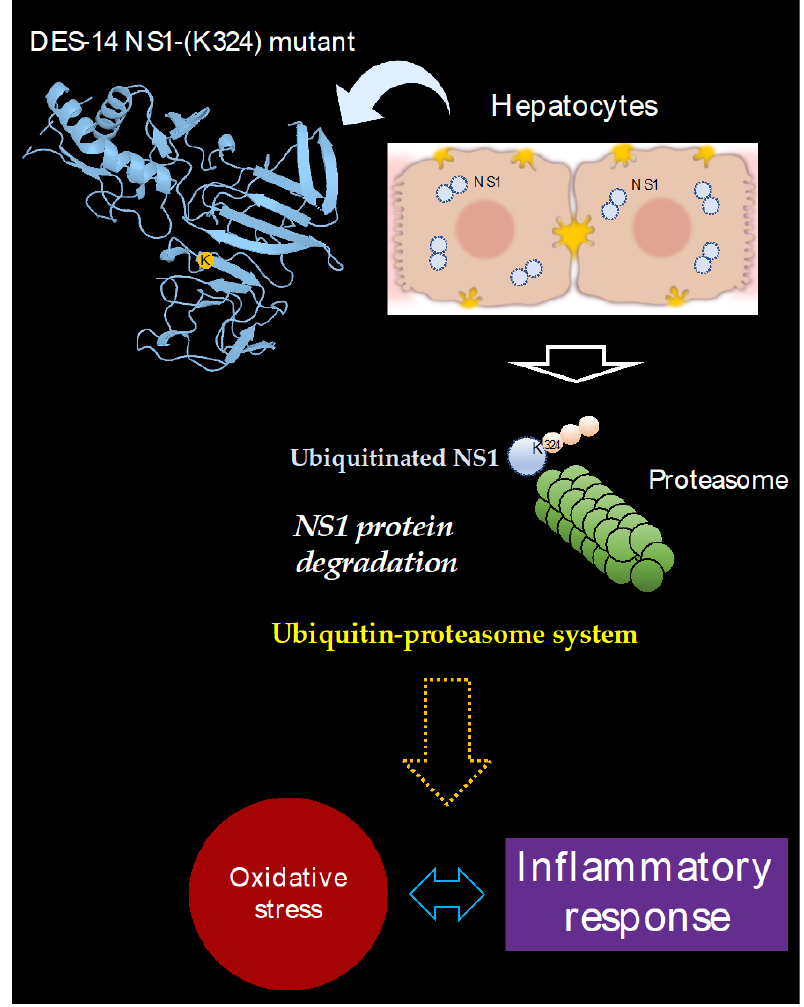
Figure 6. Expression of DES-14 NS1 protein mutant bearing a lysine residue at position 324 (DES- 14 NS1-(K324) mutant) is associated to oxidative stress and inflammatory in human hepatoma Huh7 cells.